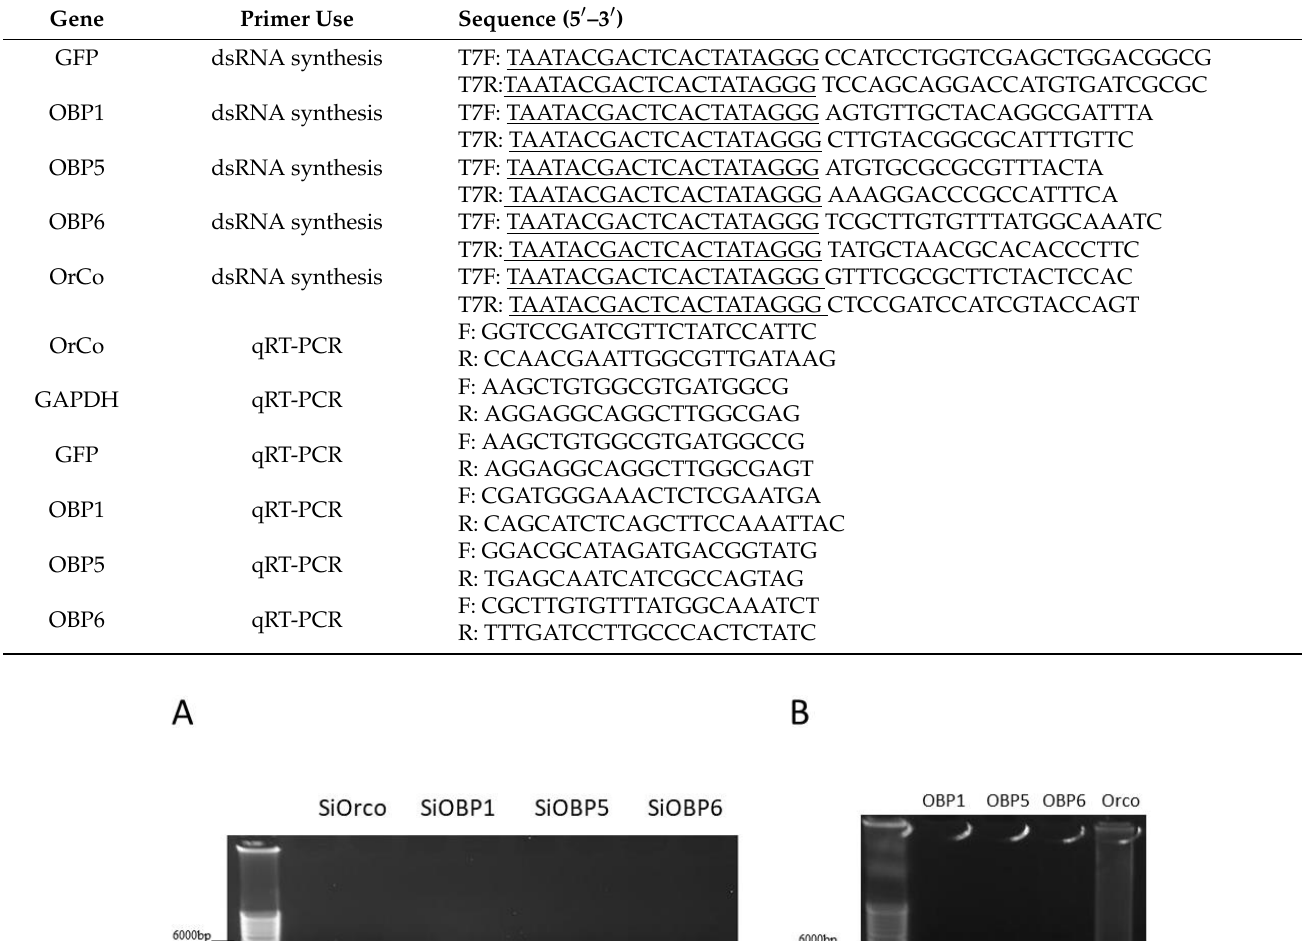
Table 1. A list of the primer sequences used for the dsRNA synthesis and real-time quantitative reverse transcriptase PCR (qRT-PCR).